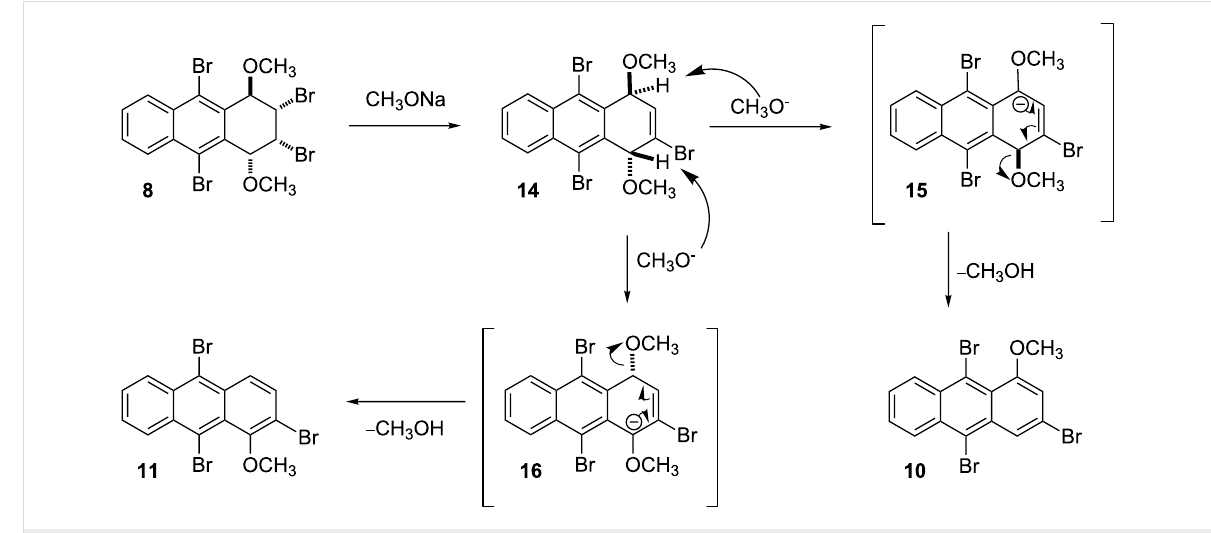
Scheme 3: The reaction mechanism for the formation of methoxyanthracenes 10 and 11 .